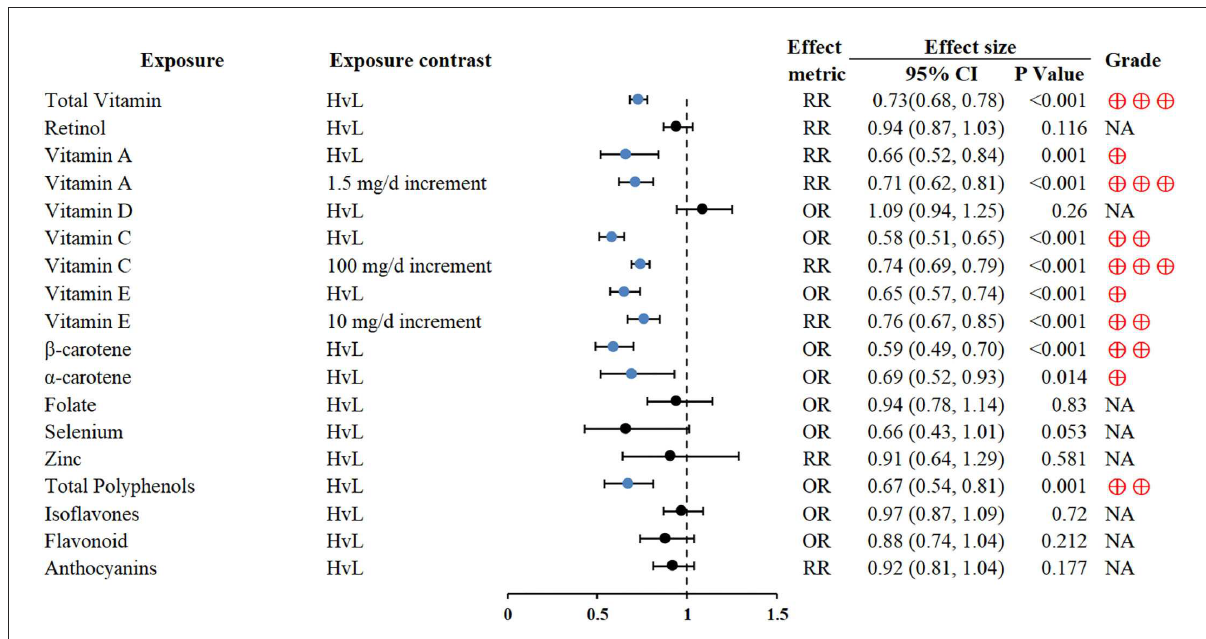
FIGURE4 Forest plot: summary effect estimates of meta-analyses reporting associations between GC and factors pertaining to micronutrients.